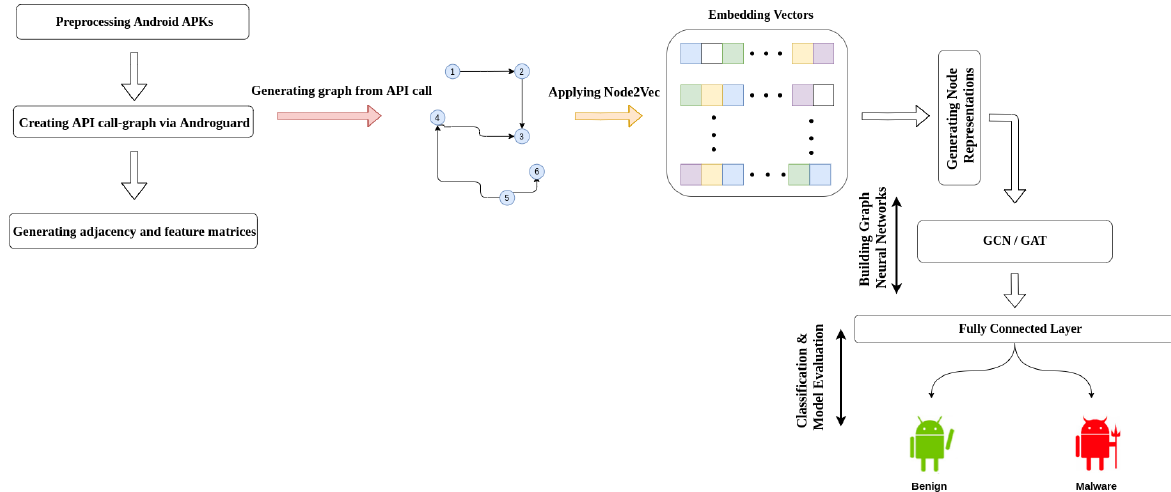
Figure 1. Diagram of proposed malware detection